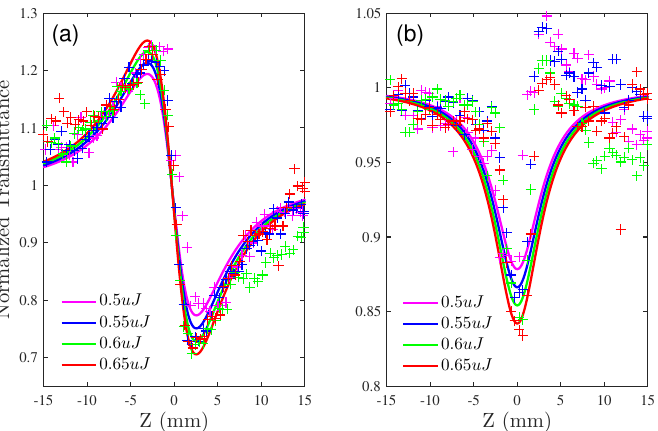
Figure 4. The experimental (dots) and fitting (solid lines) results of the Z-scan measurements for the 15 µ m-thick p -Si sample for a pulse with wavelength of 2.4 µ m and the incident fluence of 0.5 (magenta), 0.55 (blue), 0.6 (green) and 0.65 µ J (red), respectively. ( a ) Closed aperture Z-scan (normalised transmittance with a 500- µ m aperture). ( b ) Open aperture Z-scan (normalised transmittance without